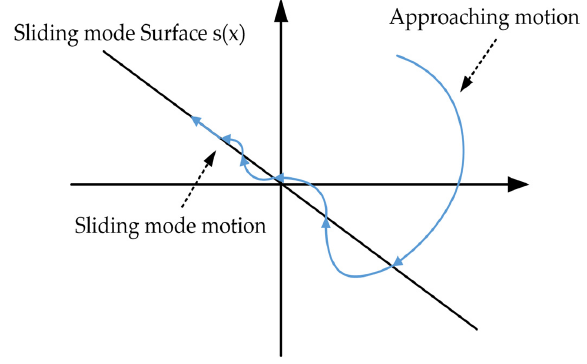
Figure 6. Schematic diagram of state motion process.